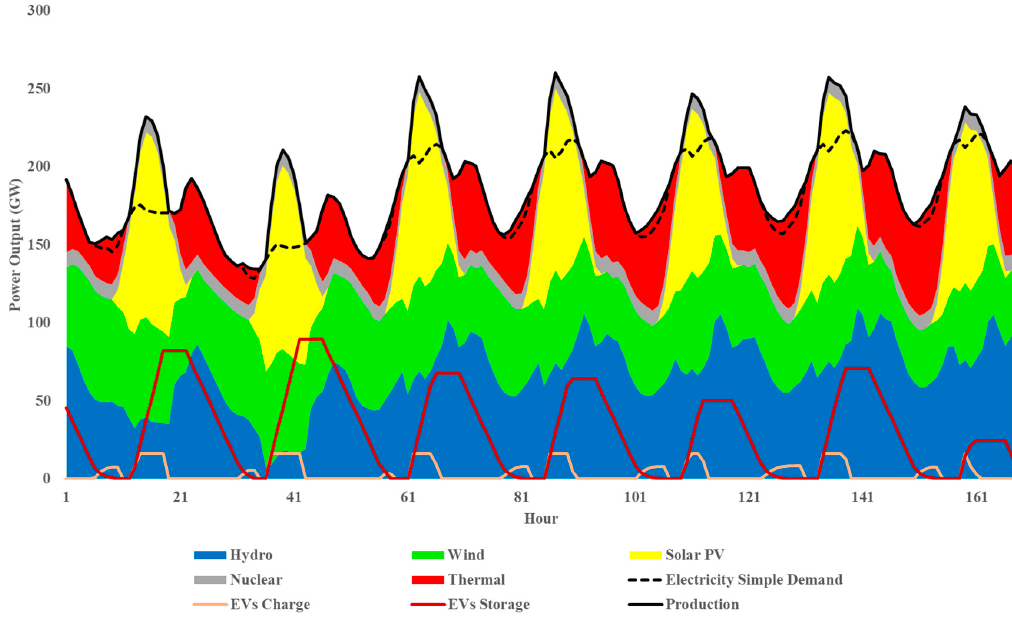
Figure 6. Power output on a spring week for scenario RES—Overnight charging strategy.